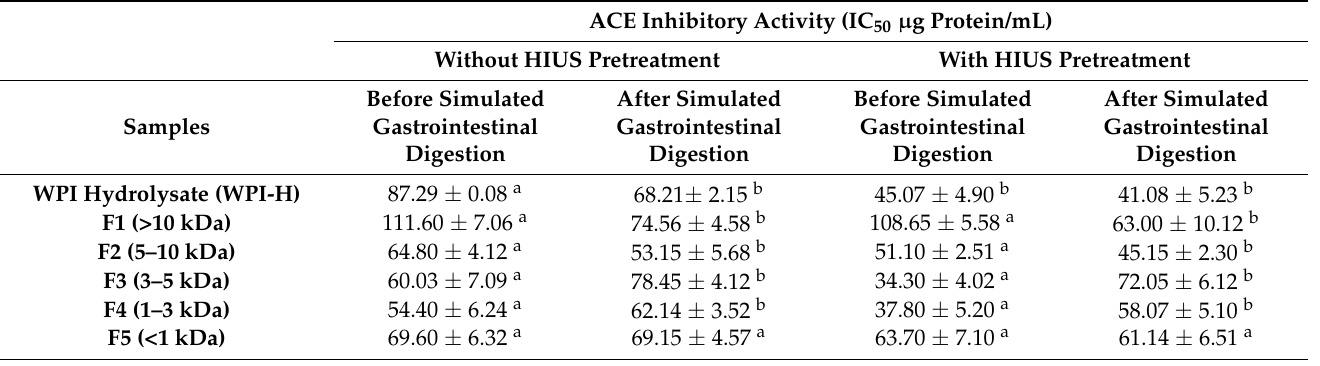
Table 1. ACE inhibitory activity of whey protein isolate hydrolysates (WPI-H) and their associated membrane fractions with and without High intensity ultrasound (HIUS) treatment, before and after simulated in vitro digestion conditions.